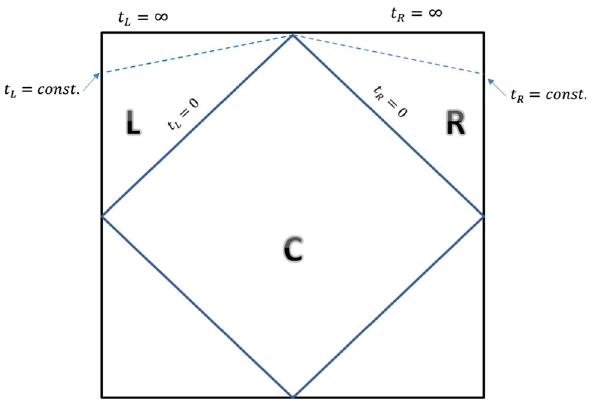
Fig. 1 The Penrose diagram of the de Sitter space, in which L and R are the two causally disconnected regions described by the open charts